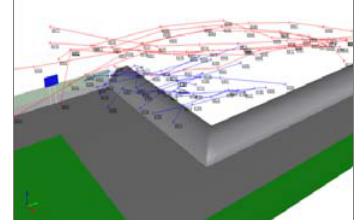
Figure 9. Paths of particle obtained by the Inertial single photogrammetry